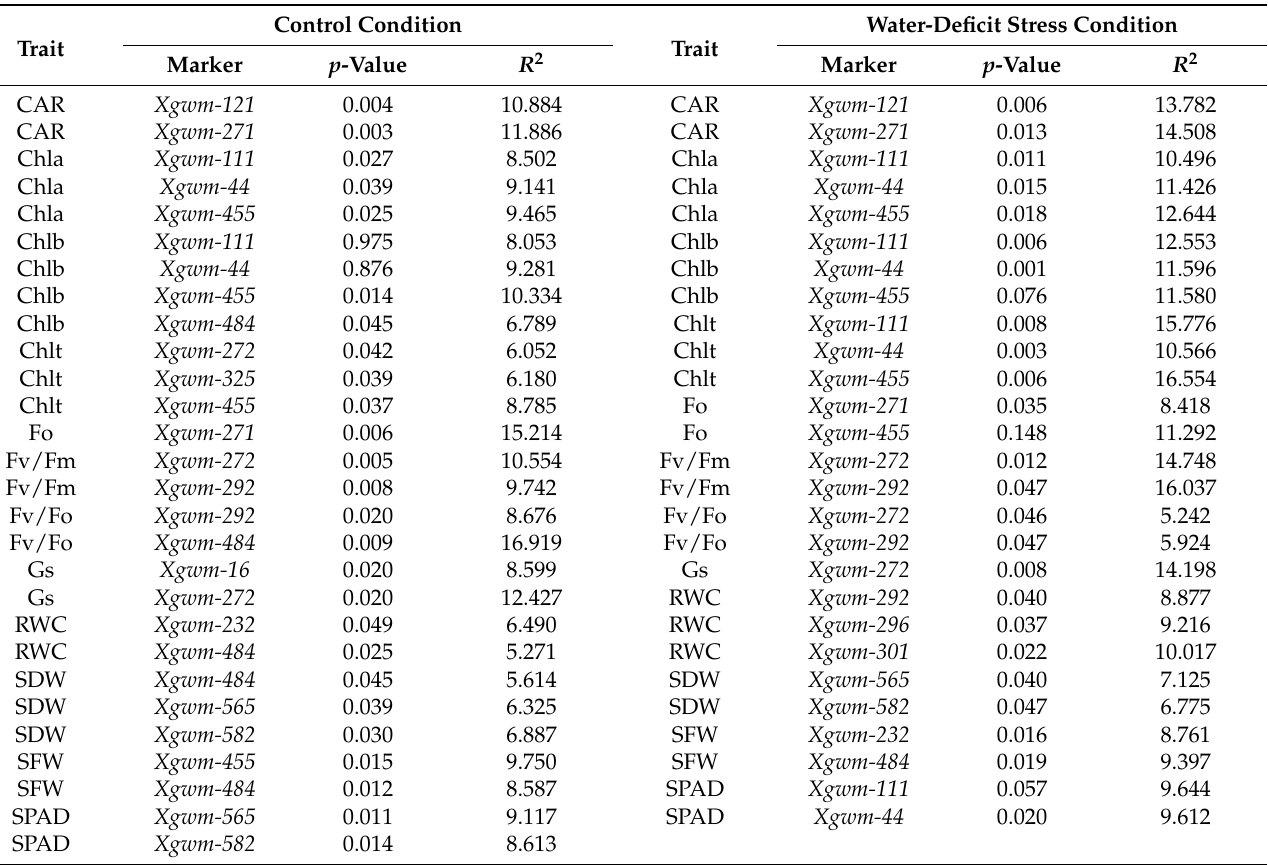
Table 5. Summary of marker–trait association analysis in Ae. tauschii and T. aestivum species under control and water-deficit stress